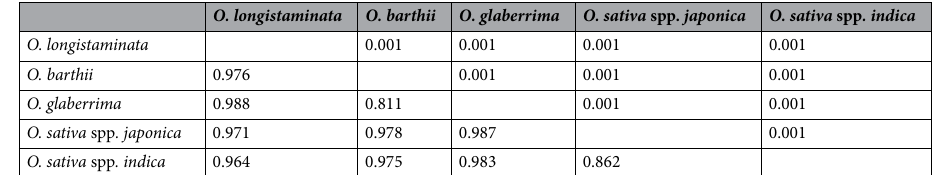
Table 2. Pairwise differentiation ( PhiPT ) among four rice species and two subspecies based on 36 KASP markers. PhiPT values are shown below the diagonal. Probability was based on 999 permutations, shown above the diagonal.